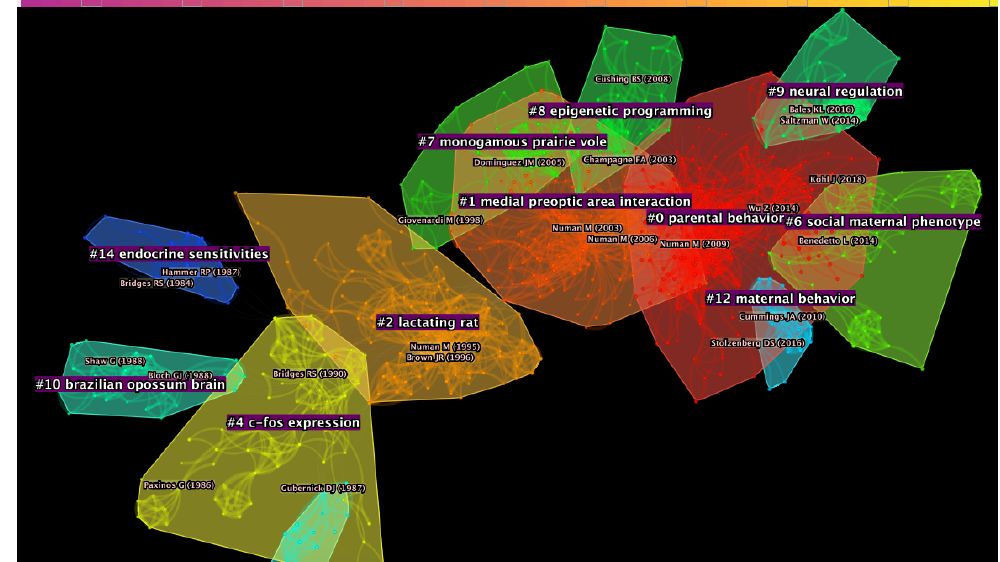
Figure 2. Network of publications generated through the Document Co-Citation Analysis (DCA). The 17 major clusters are highlighted and divided by